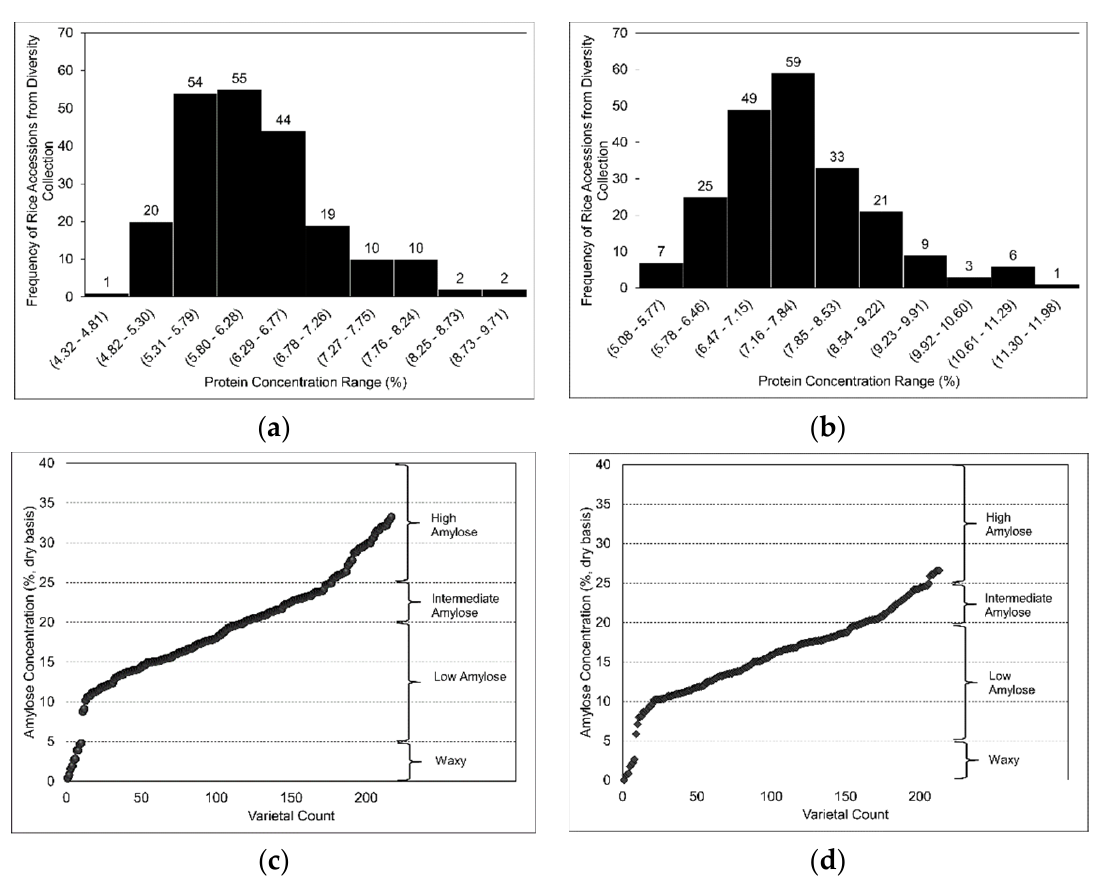
Figure 1. Frequency distribution of protein ( a , b ) and apparent amylose ( c , d ) concentrations of the diverse rice accessions from the 2018 ( a , c ) and 2019 ( b , d ) seasons. Table 1. Frequency distribution of rice lines based on apparent amylose concentration from pheno- typing in Beaumont, Texas in 2018 and